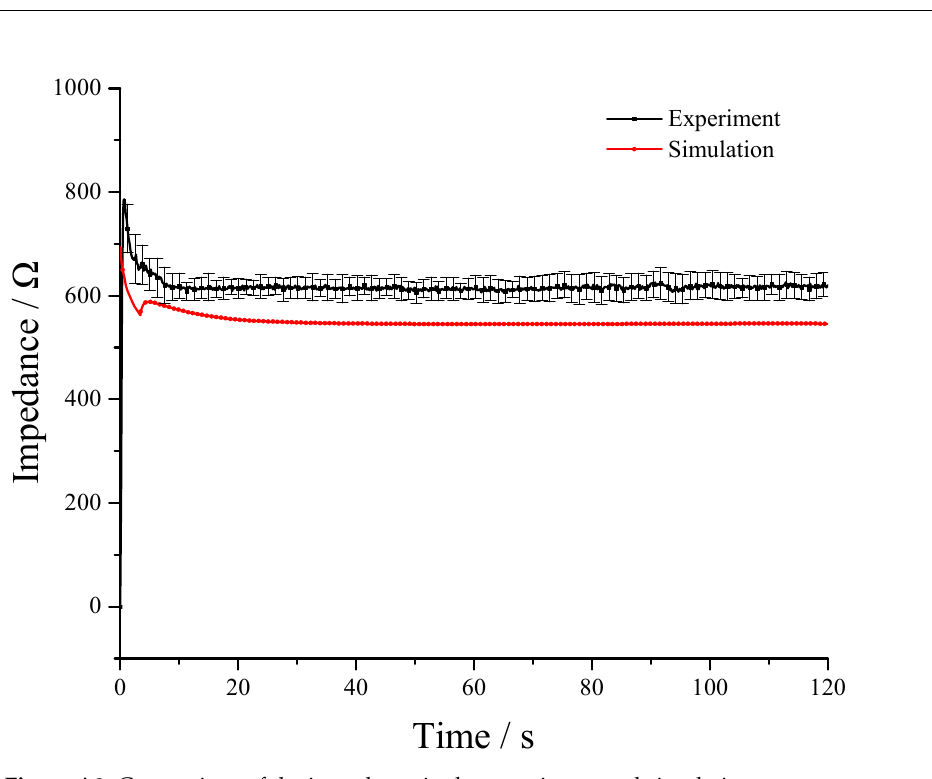
Figure A3. Comparison of the impedance in the experiment and simulations.